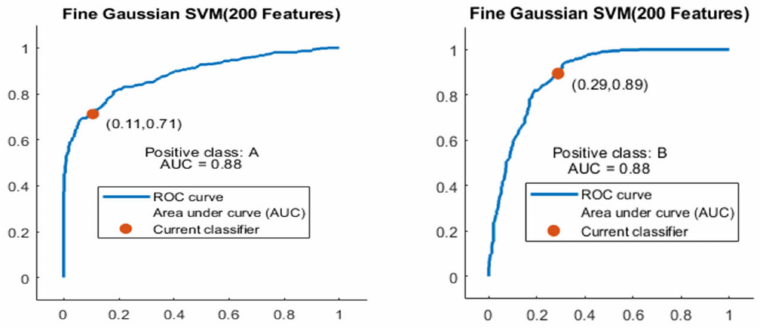
Figure 13. ROC curves for two classes A and B with 200 features and using 5-fold